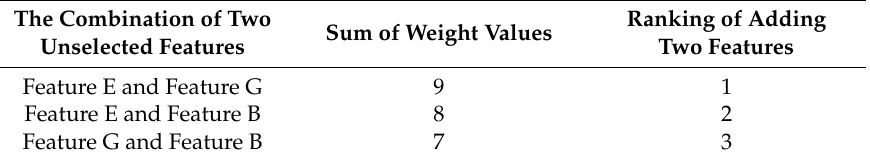
Table 2. Weight sum of two unselected features and their ranking.